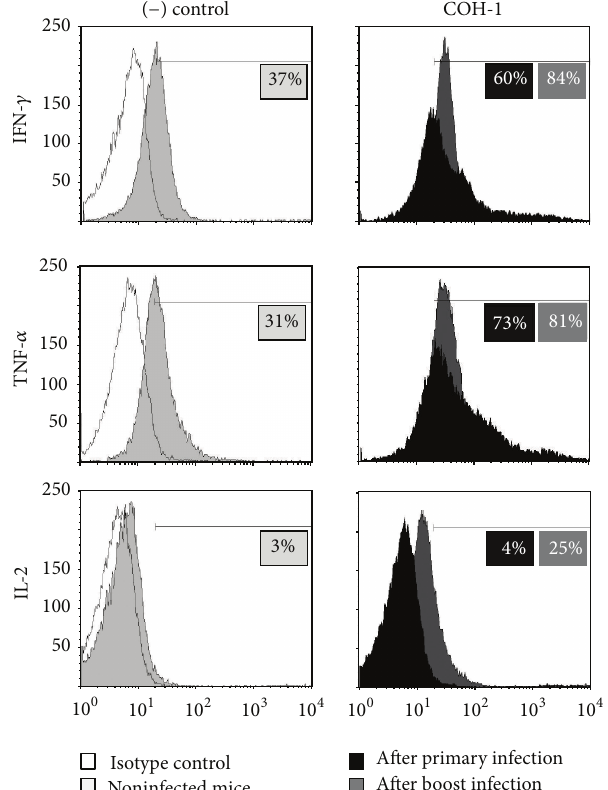
Figure5: In vivo CD4 + TcellcontributiontocytokineproductionduringprimaryandsecondaryGBSinfections.C57BL/6micewereinjected intraperitoneally with a dose of 10 6 CFU of wild-type GBS serotype III strain COH-1. Surviving animals who had previously displayed clinical signs were boosted with a second dose of 10 6 CFU of GBS strain COH-1 two weeks after initial infection. Spleens of animals with clinical signs and positive bacteremia were harvested 96 h after primary infection or 48 h after boost infection ( 𝑛 = 2 per group × 5 individual experimental infections). Five hours prior to spleen collection, mice were injected with Brefeldin A (200 𝜇 g). ( − ) Control animals were similarly treated. Splenic CD4 + T cells were MACS-purified, stained intracellularly for different cytokines, and analyzed by FACS. Representative data from 5 different experimental infections. Cytokine basal expression levels in ( − ) control animals were similar at 96 h after primary mock-infection and 48 h after secondary mock-infection. Representative histograms from the latter time point were selected for the figure. Twenty thousand gated events were acquired per sample and data analysis was performed using CellQuest software. Histograms were drawn based on PE- control stain and were plotted on logarithmic scales. It should be noted that isotype controls are the same in both groups, but only displayed on left panels to simplify the